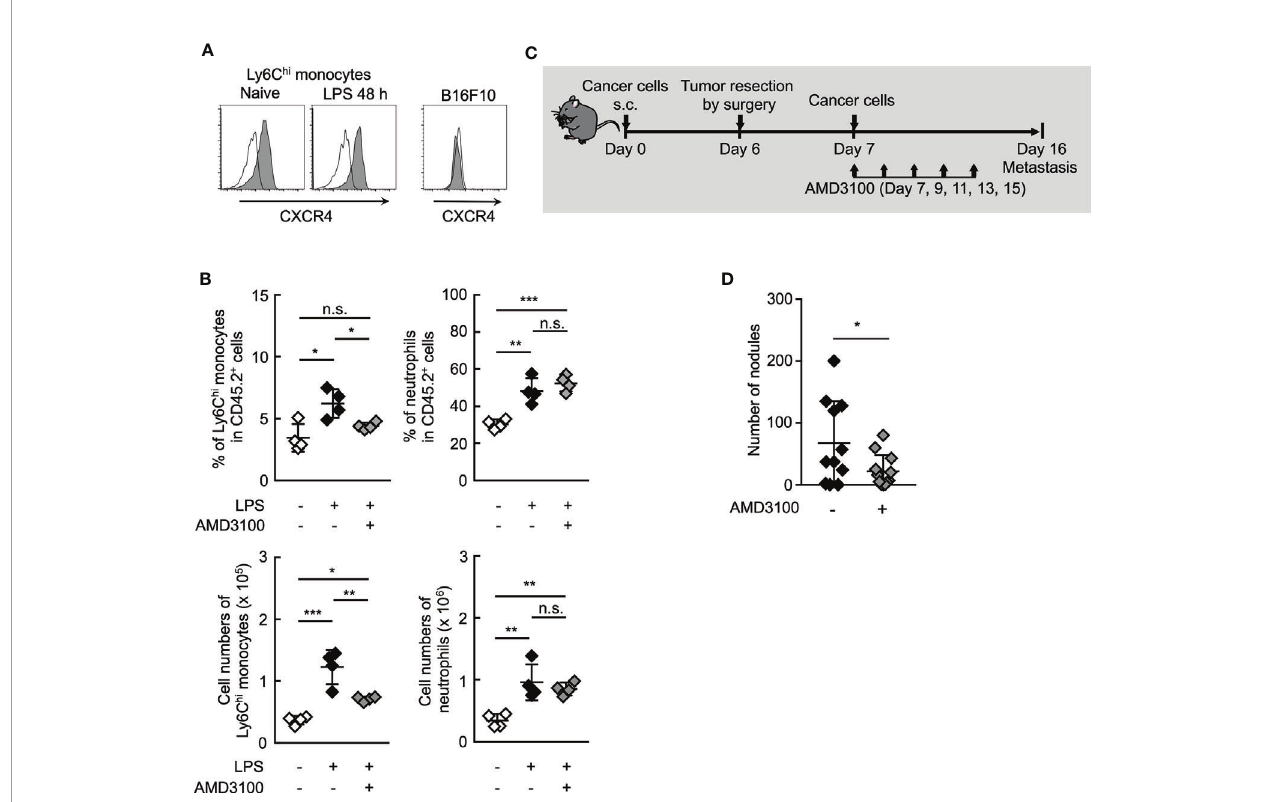
FIGURE 6 | Inhibition of CXCR4 signaling reduce lung metastasis by Ym1 + Ly6C hi monocytes. (A) Expression of surface CXCR4 on peripheral blood Ly6C hi monocytes isolated from naïve or LPS-treated mice, or B16 cells. Black lines indicate isotype control. (B) Inhibition of lung accumulation of Ly6C hi monocytes by treatment with CXCR4 antagonist. WT mice injected intravenously with LPS (20 µg) and treated i.p. with AMD3100 (5 mg/kg, -1 h before and 24 h after LPS injection) or PBS [inhibitor (-)]. Average values are shown with SD. One-way ANOVA followed by Dunnett ’ s test, n = 4. *** P < 0.005; ** P < 0.01; * P < 0.05; n.s., not signi fi cant. Each symbol represents an individual animal. (C, D) Effects of CXCR4 antagonist on lung metastasis after tumor resection. (C) Experimental design used to test the effect of AMD3100 treatment on tumor-resection-induced metastatic progression. B16 cells (1 x 10 6 cells) were s.c. inoculated in the fl ank of WT mice. Six days later, the primary tumor was removed by surgery followed by i.v. injection of B16 cells (1 x 10 5 cells) 24 h later. AMD3100 (5 mg/kg) or PBS [inhibitor (-)] was injected into these mice on Day 7, 9, 11, 13, and 15. The lungs were analyzed for metastasis on Day 16. (D) Quantitative summary of the number of lung metastases. Average values are shown with SD. Unpaired two-tailed t-test, n = 10 – 11. * P < 0.05. Each symbol represents an individual